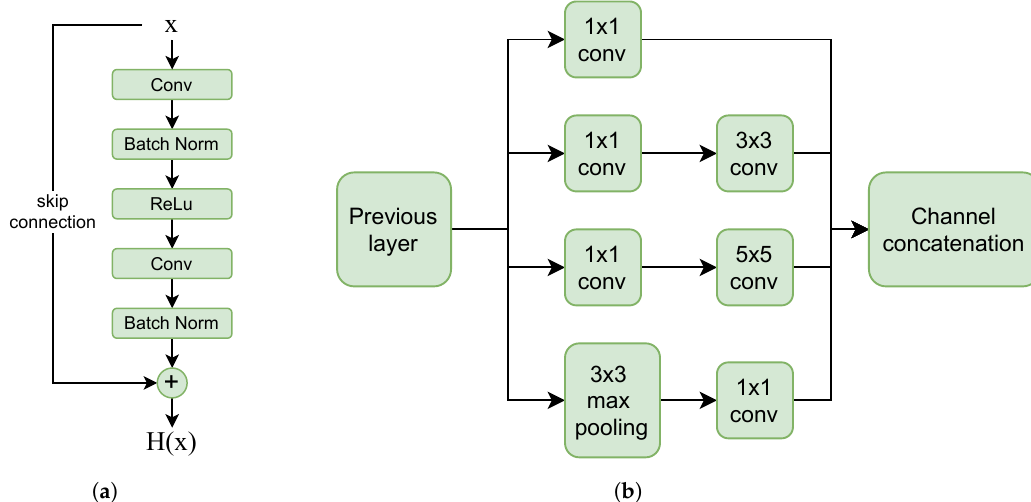
Figure 6. ( a ) Res block; ( b ) inception